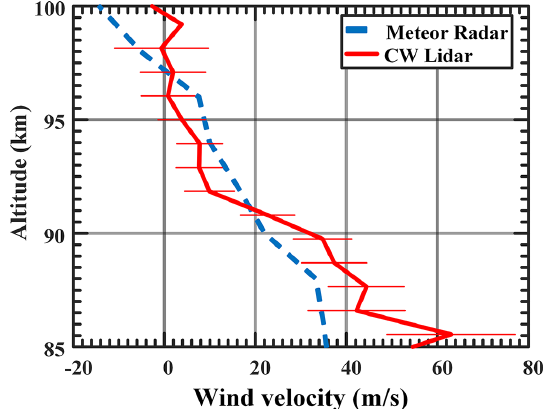
Figure 10. Comparison of nightly mean zonal wind profile between PMCW-NSL (solid red line) and meteor radar (dashed blue line) on 1 December